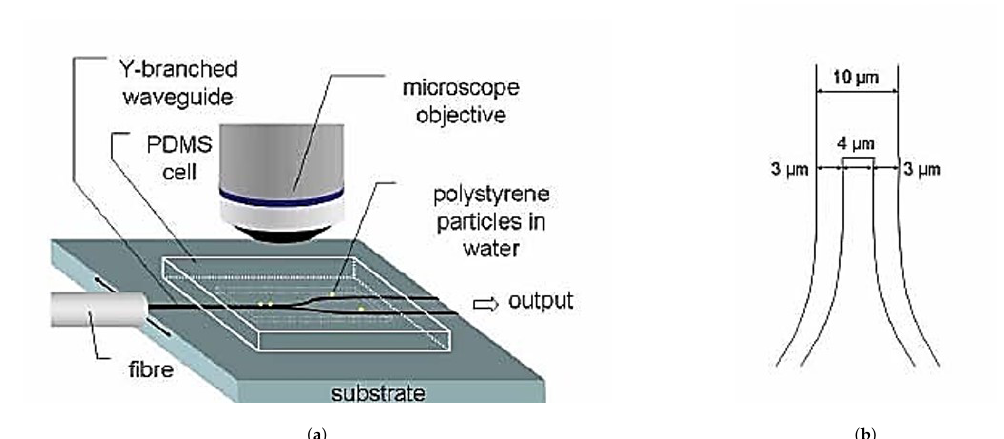
Figure 9. ( a ) the setup of a Y branched sorter and ( b ) the waveguide structure and widths of each branch. Reprinted with permission from [74] © The Optical Society.